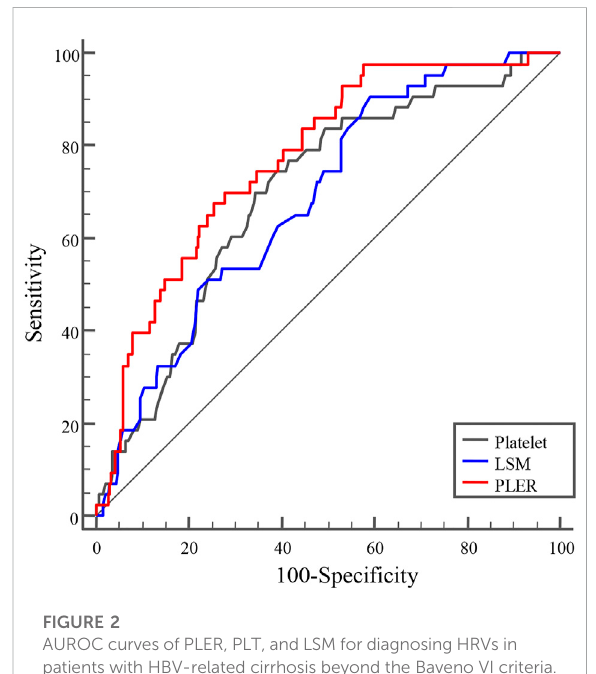
FIGURE 2 AUROC curves of PLER, PLT, and LSM for diagnosing HRVs in patients with HBV-related cirrhosis beyond the Baveno VI criteria. AUROCs of PLER, PLT, and LSM were 0.771 (95% con fi dence interval [CI]: 0.720 – 0.817), 0.697 (95%CI: 0.643 – 0.748), and 0.685 (95%CI: 0.630 – 0.736), respectively. AUROC, area under receiver operating characteristic curve; HRVs, high-risk varices; LSM, liver stiffness measurement; PLER, platelet count: liver stiffness measurement ratio; PLT, platelet